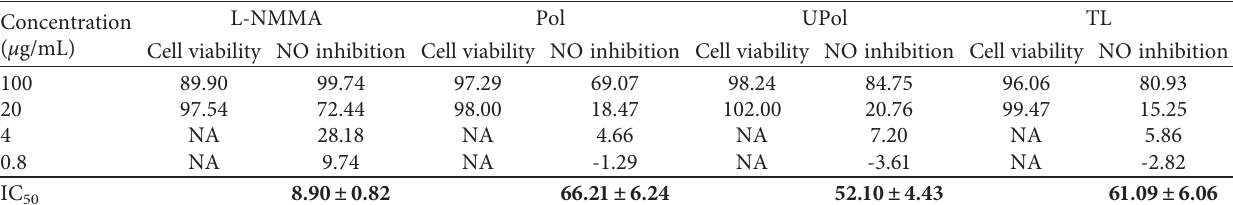
Table 6: The NO inhibition and the cell viability of lipid